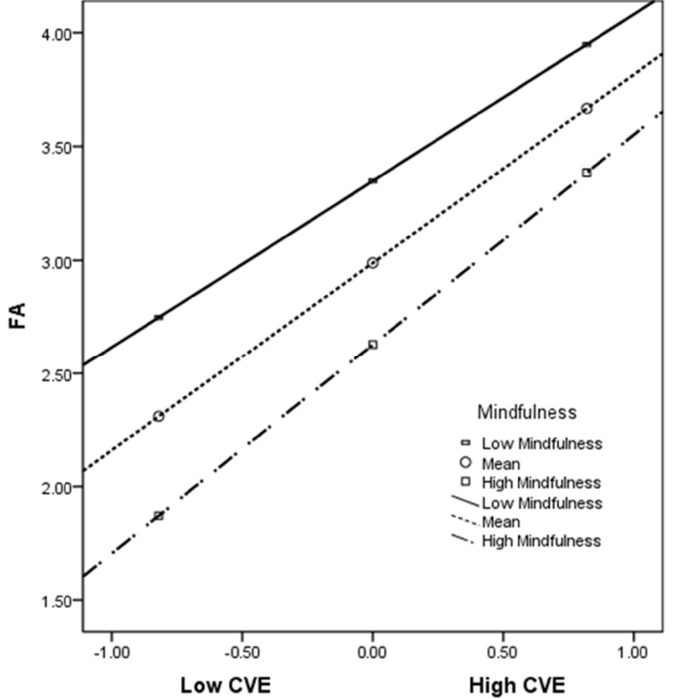
Figure 2. Moderating effect of mindfulness. CVE, COVID-19 victimization experience; FA, future anxiety.